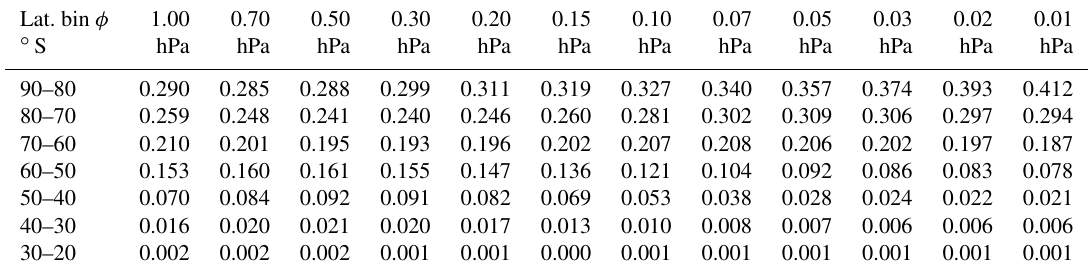
Table A1. Normalized latitudinal distribution (cid:57)(φ,z) of EPP-NO y densities and fluxes in SH winters as a function of pressure level. Lat. bin φ